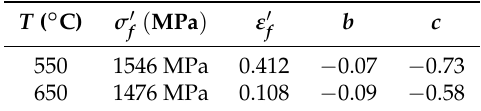
Table 6. Uniaxial fatigue property of GH4169 at different temperatures.